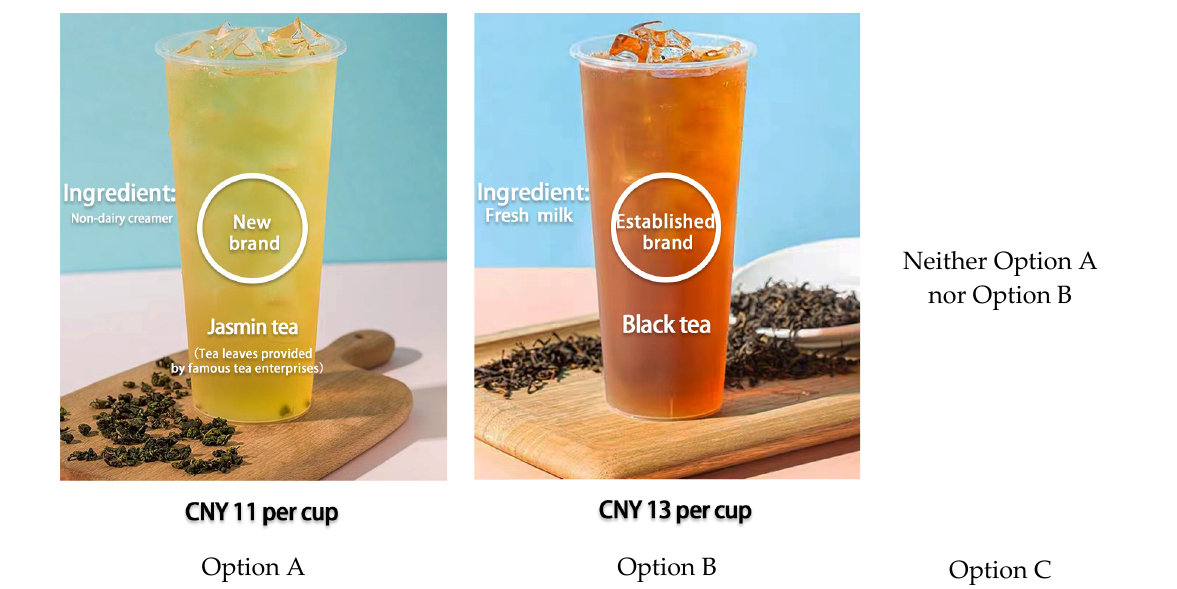
Figure 2. An example of a choice set in the questionnaire.